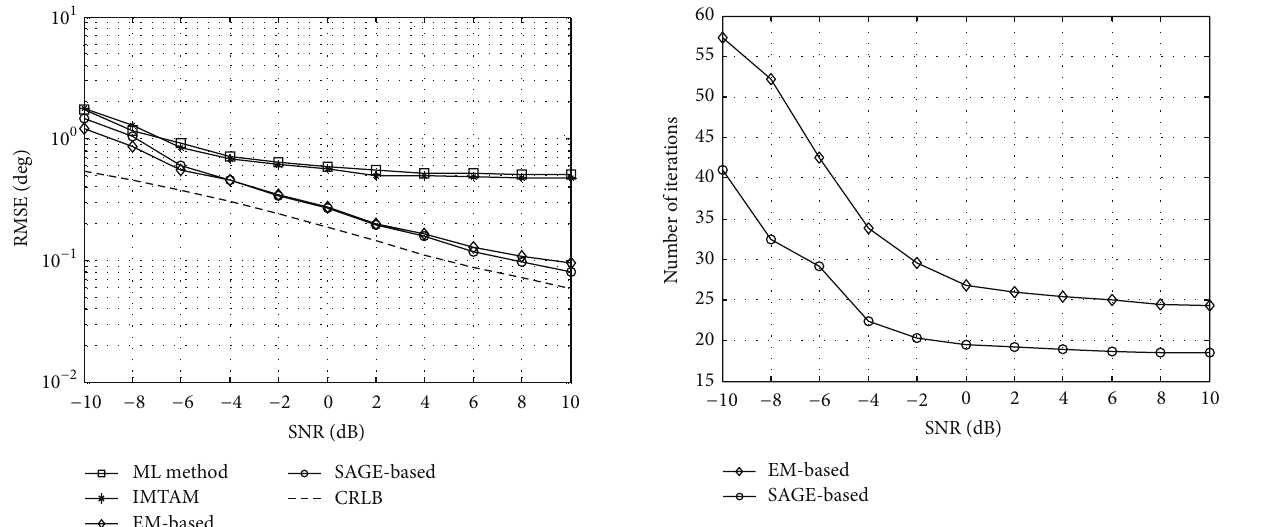
Figure 4: RMSE of DOA estimates of different methods against SNR.